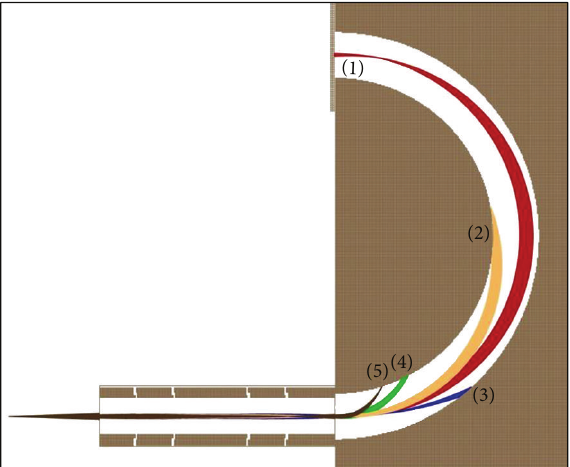
Figure 8: Focus of the electron beam at the entrance lens systems and SIMION simulations of electron trajectories with electron energies of (1)—50, (2)—45, (3)—70, (4)—30, and